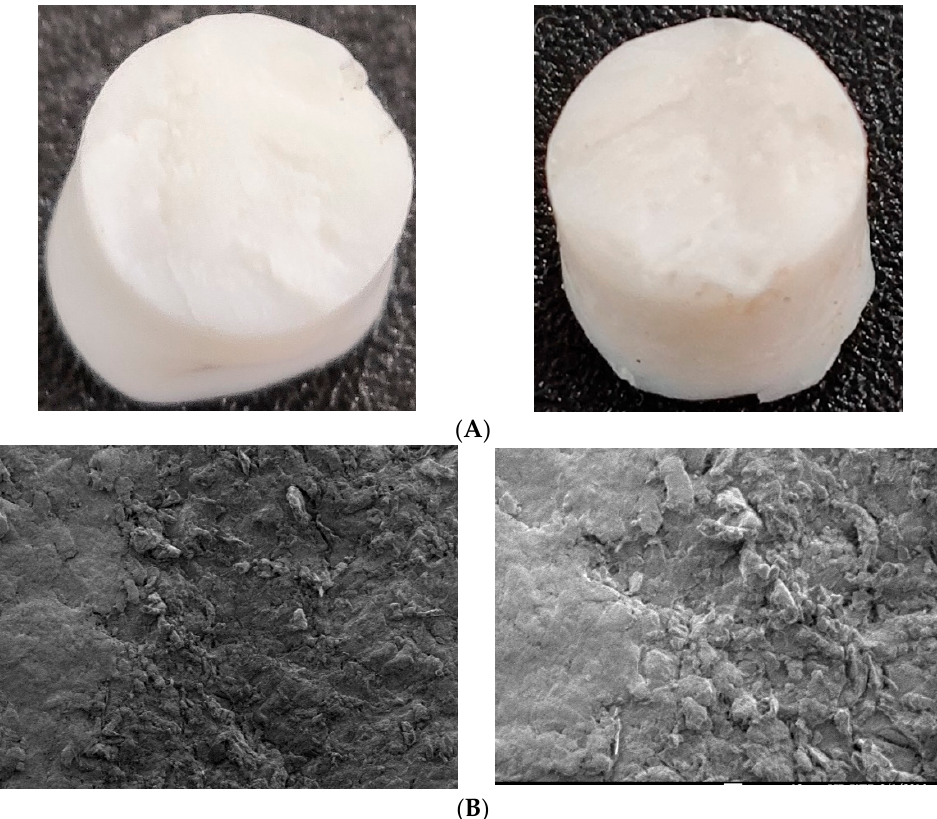
Figure 8. ( A ) Typical fractured surface cracked near the fretting zone. ( B ) Debris and striations near canal type rupture.